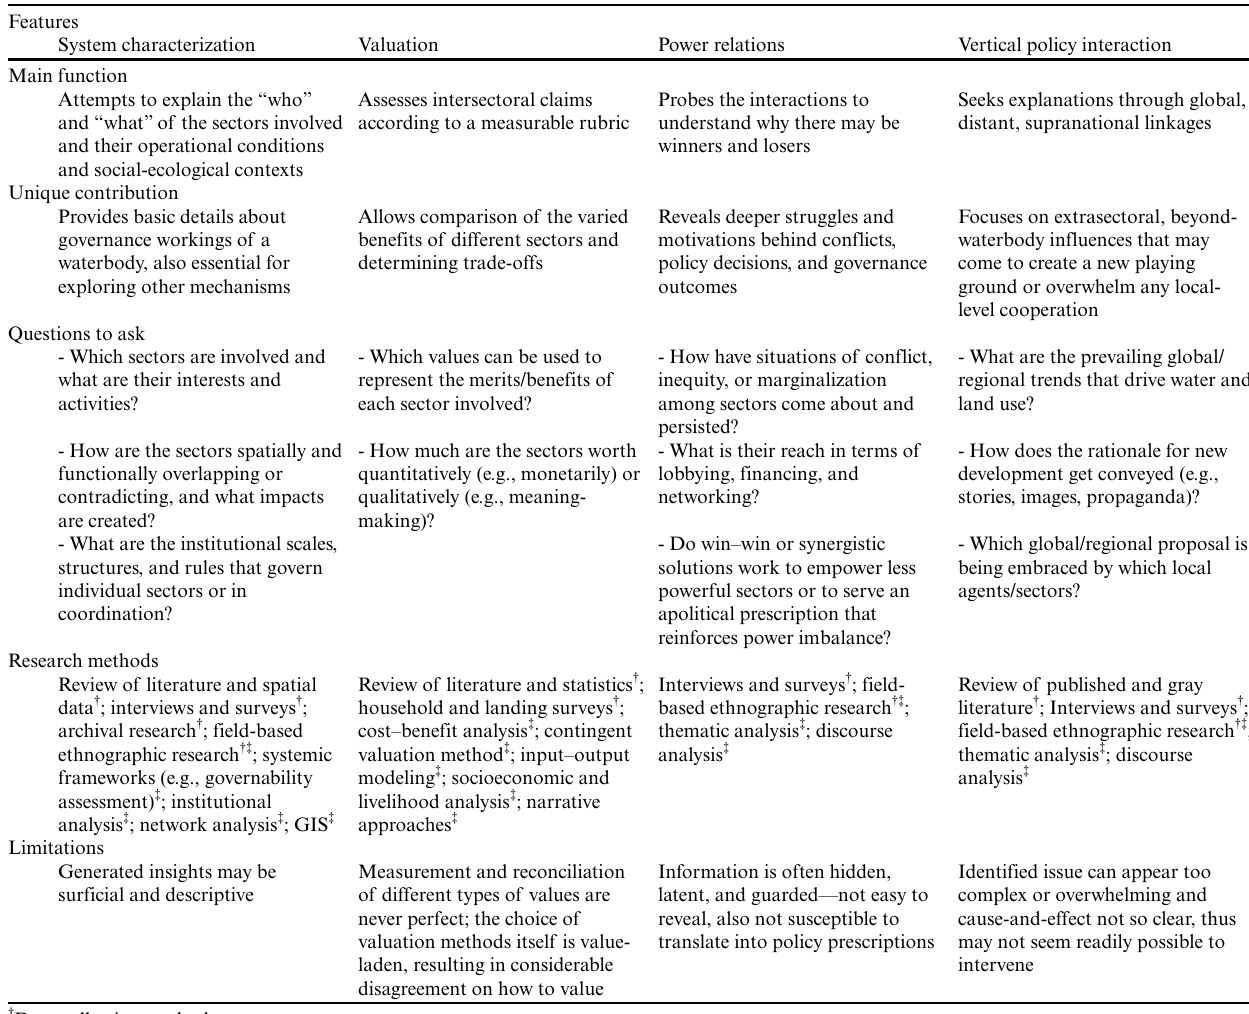
Table 1. Summary of the key features of the four mechanisms that reveal and influence intersectoral relationships in the governance of inland